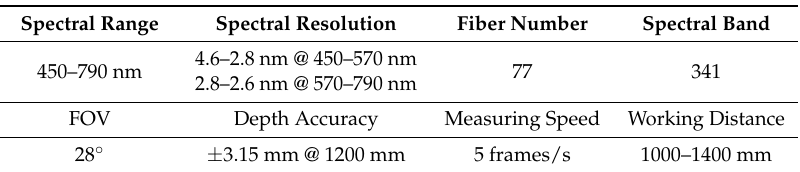
Table 3. Parameters of the integrated system.